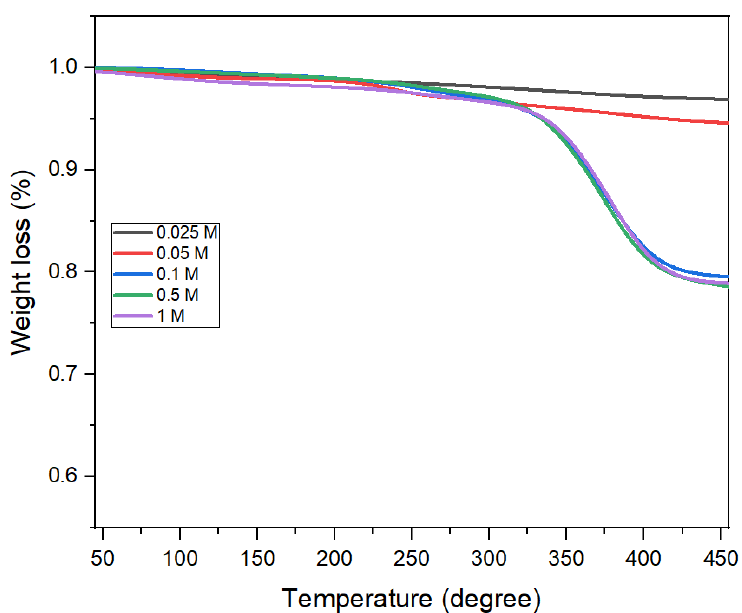
Figure 11. TGA results of cobalt ferrite nanoparticles synthesized at 180 °C, 16 h with different oleic acid concentrations.